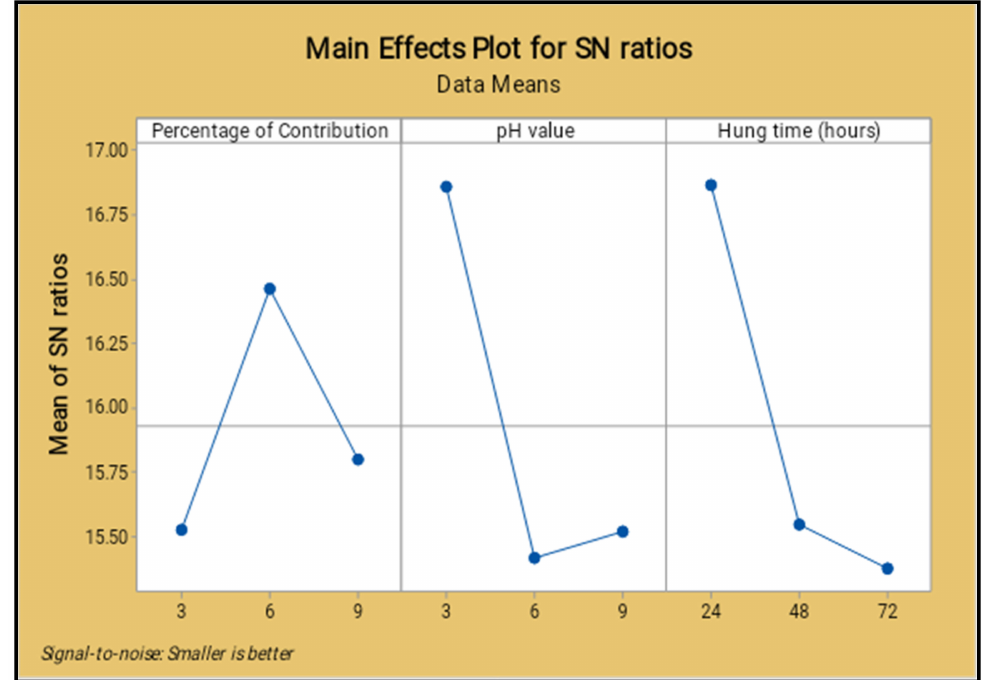
Figure 23. Main effect plot for signal to noise ratio (salt spray test).